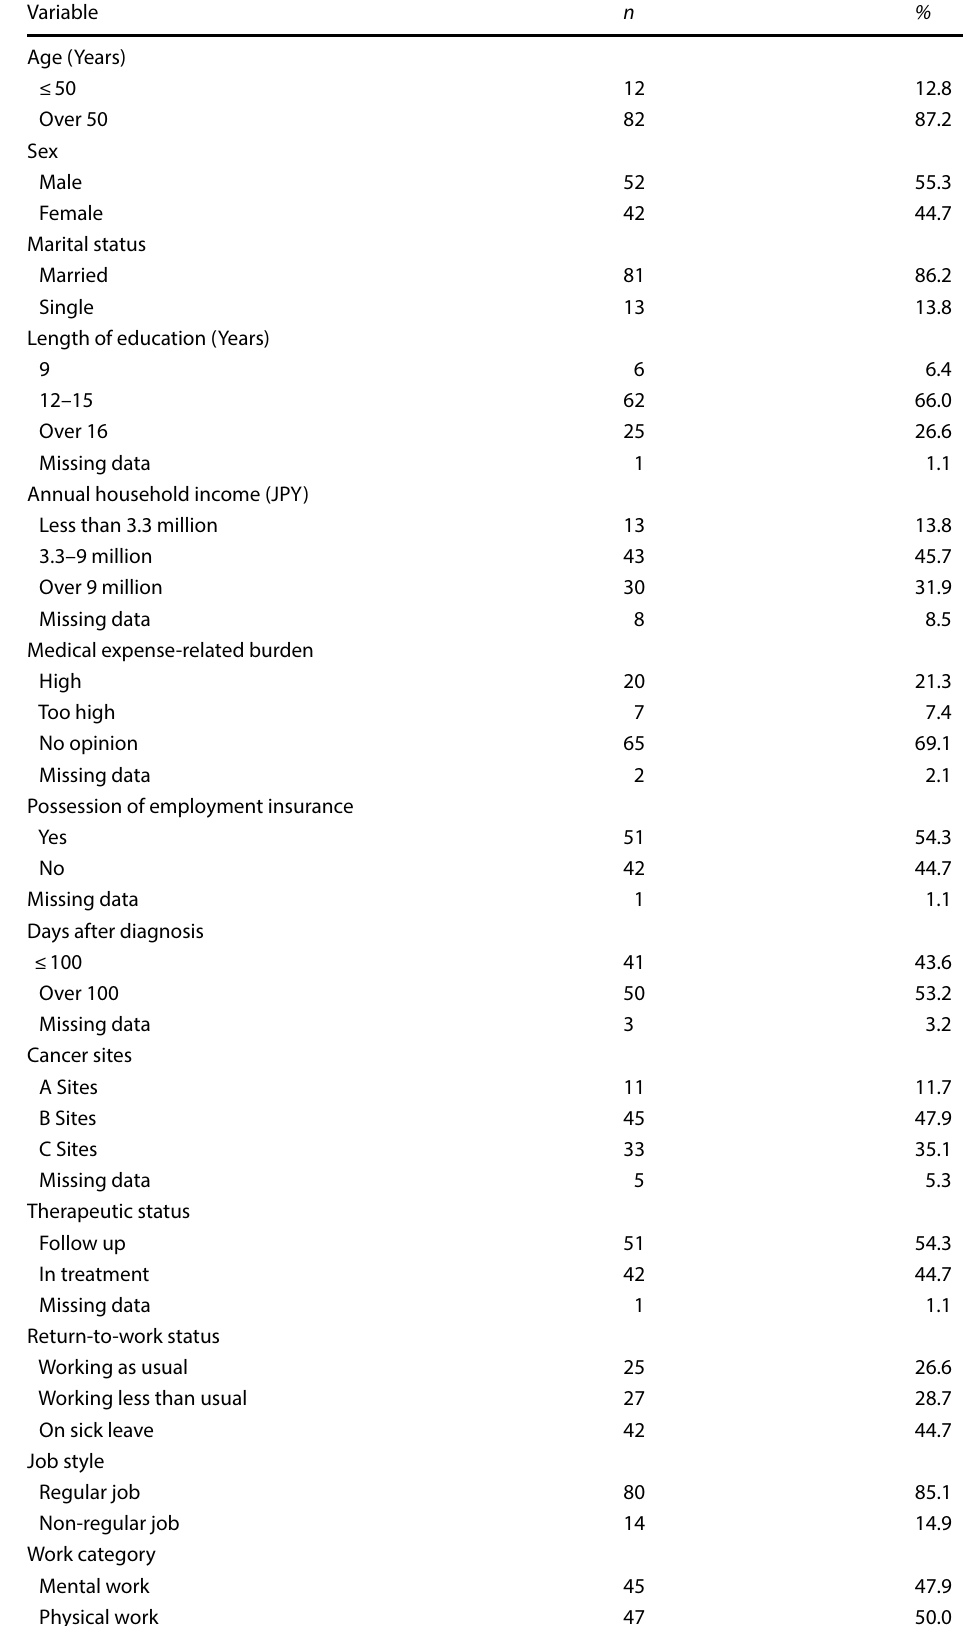
Table 1 Characteristics of study